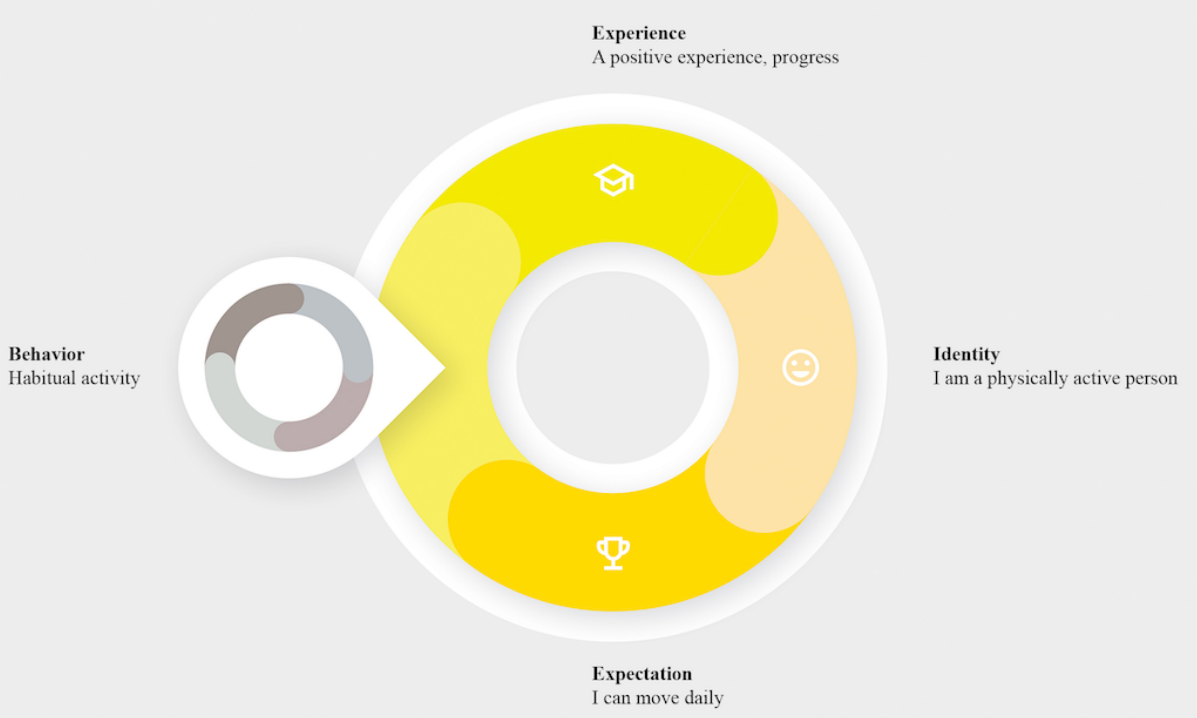
Figure 1. The relationship between the identity loop and the habit